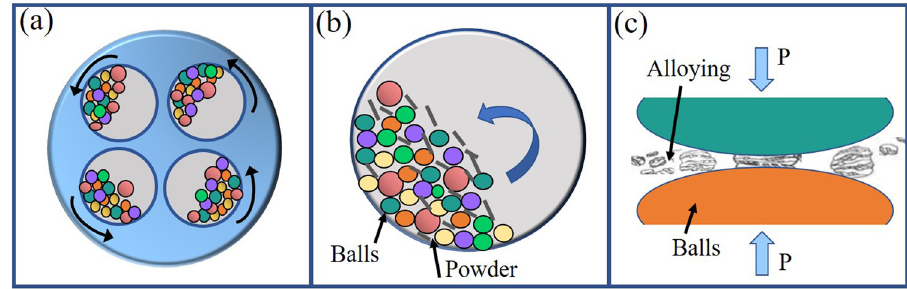
Figure 2: ( a ) Schematic diagram of ball milling, ( b ) enlarged view of ball milling tank, and ( c ) alloying process during ball